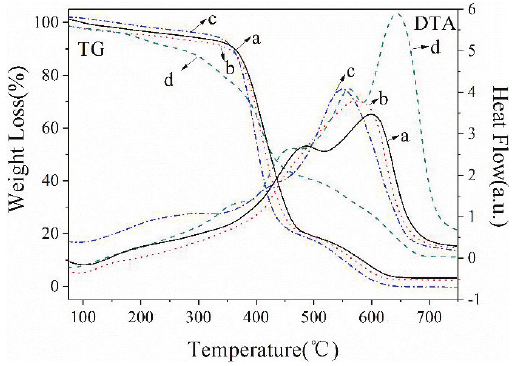
Figure 4: TG-DTA curves of: a – pure copolymer P (2VPco1MA), b – P (1VPco1MA), c – P (1VPco2MA), d – composite film PWA/P (1VPco1MA).